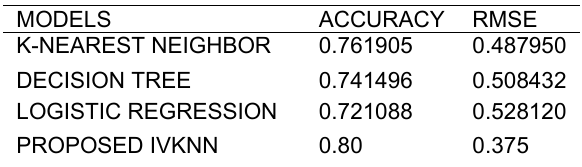
Table 2. Comparison between Existing and proposed Model